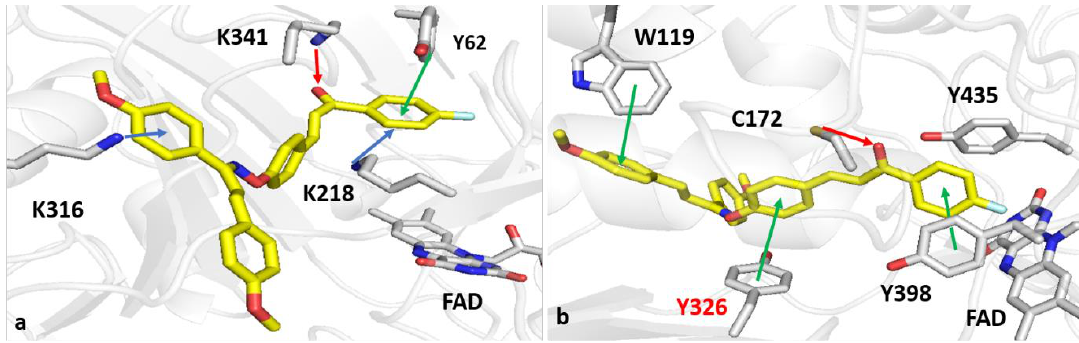
Table 2. Docking scores and ΔG binding values of lead compounds with MAO -A and MAO-B. Docking Score (kcal/mol) Δ G binding (kcal/mol) Figure 5. Top scored poses of COE-22 in the binding sites of MAO-A ( a ) and MAO-B ( b ). Proteins are rendered as white cartoons, while ligands are rendered as yellow sticks. Green, blue and red arrows indicate π − π interactions, cation- π interactions and hydrogen bonds, respectively. Y326, responsible for MAO-B selectivity, is labeled red.